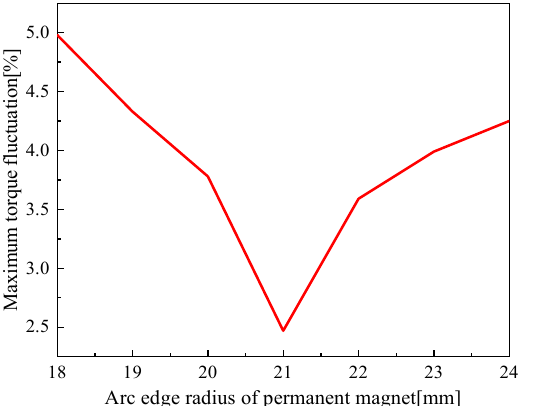
Figure 14. Relationship between the radius of the arc edge of the permanent magnet and torque ripples.